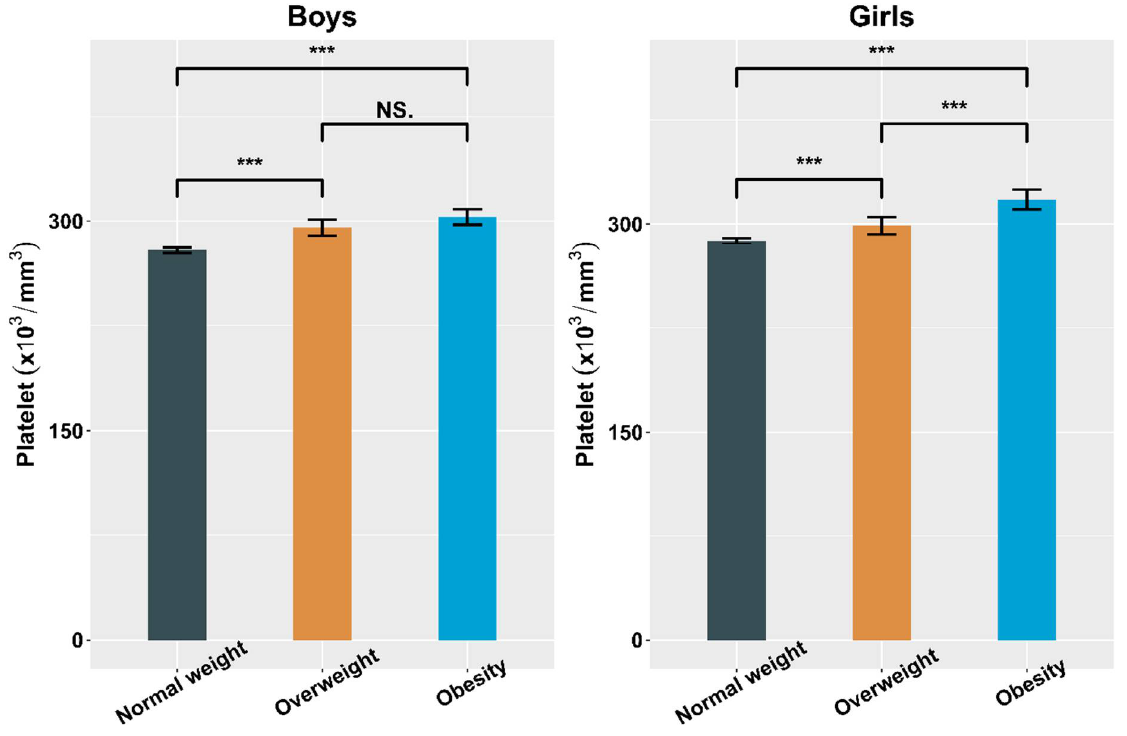
Figure 2. Mean white blood cell (WBC), red blood cell (RBC), hemoglobin, hematocrit, and platelet levels according to sex and obesity. ( a ), Mean white blood cell (WBC) according to sex and obesity;